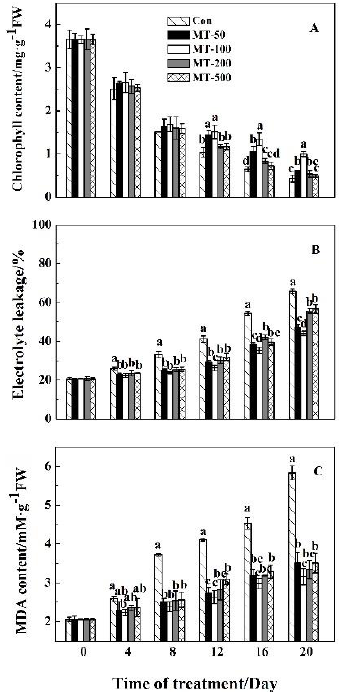
Figure 2. Effects of MT on the contents of chlorophyll ( A ), electrolyte leakage ( B ) and MDA content ( C ) of detached grapevine leaves during dark-induced senescence. Different letter indicates significant differences at the level of 0.05.